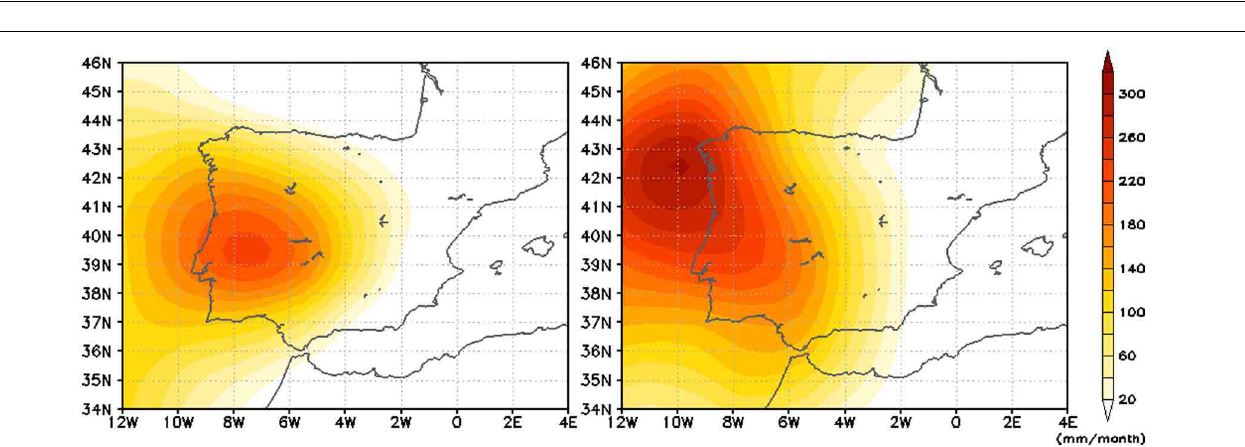
FIGURE 9 | November NAO index from 1865 to 2012.